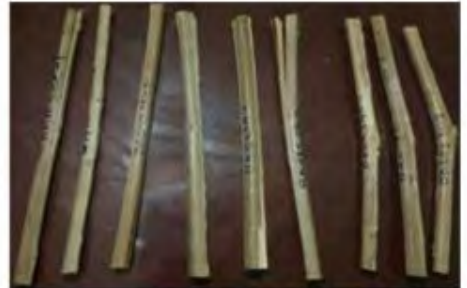
Figure 35. The failure patterns of the Variable Span Method specimens (Author’s own, n.d.)